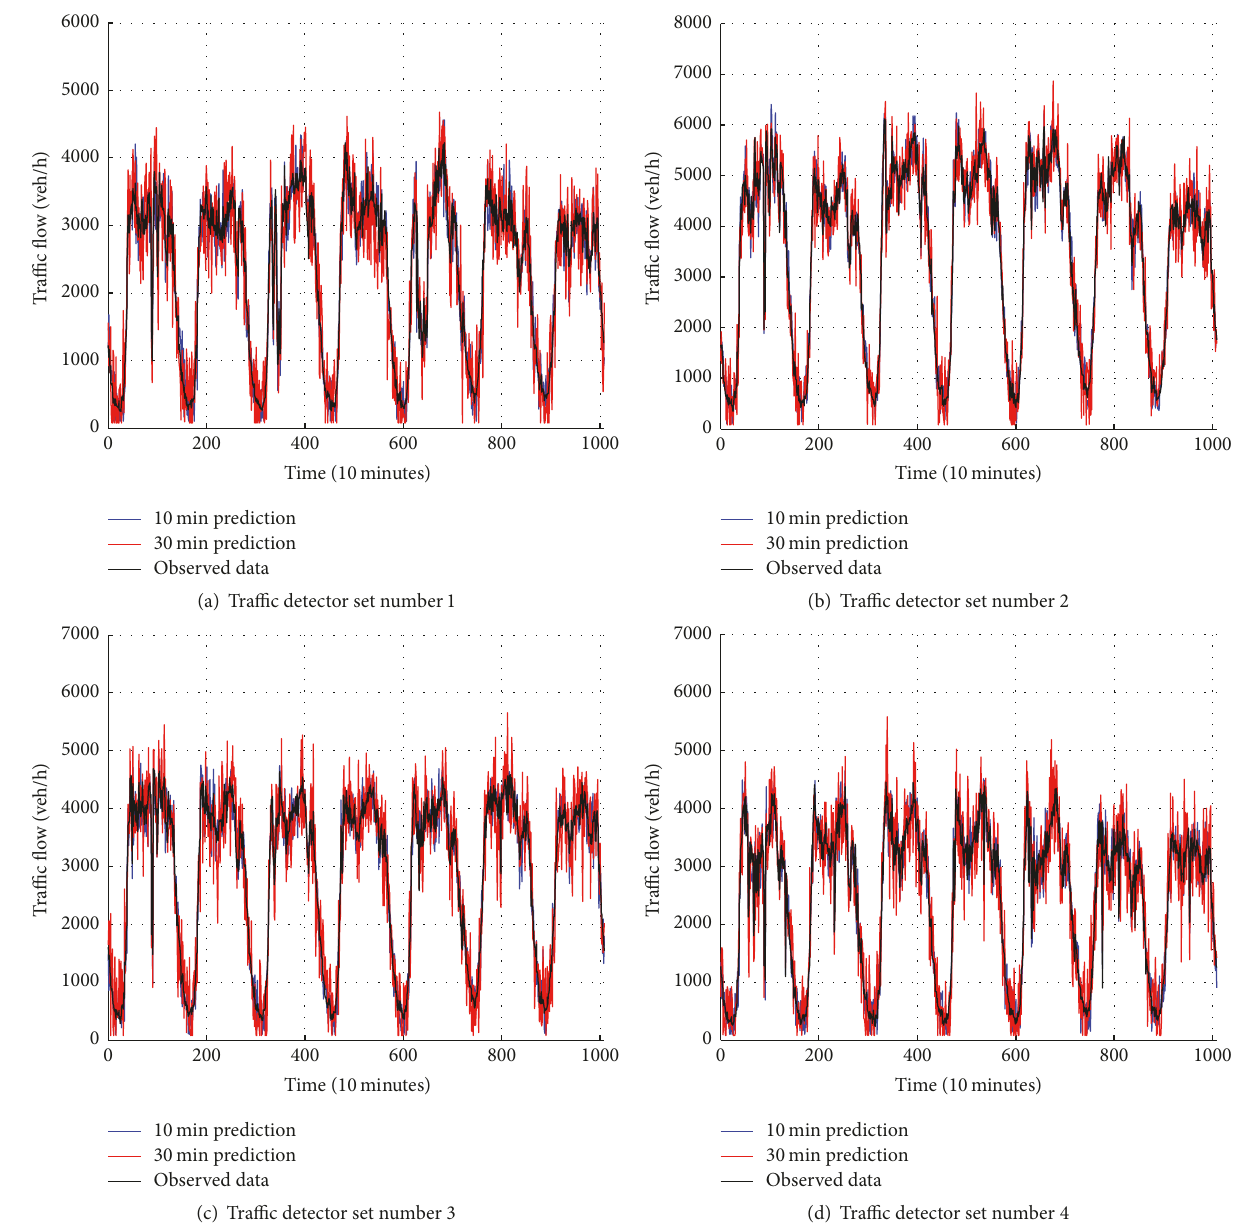
Figure 6: Predicted and observed traffic flow count data for the four detector sets by using